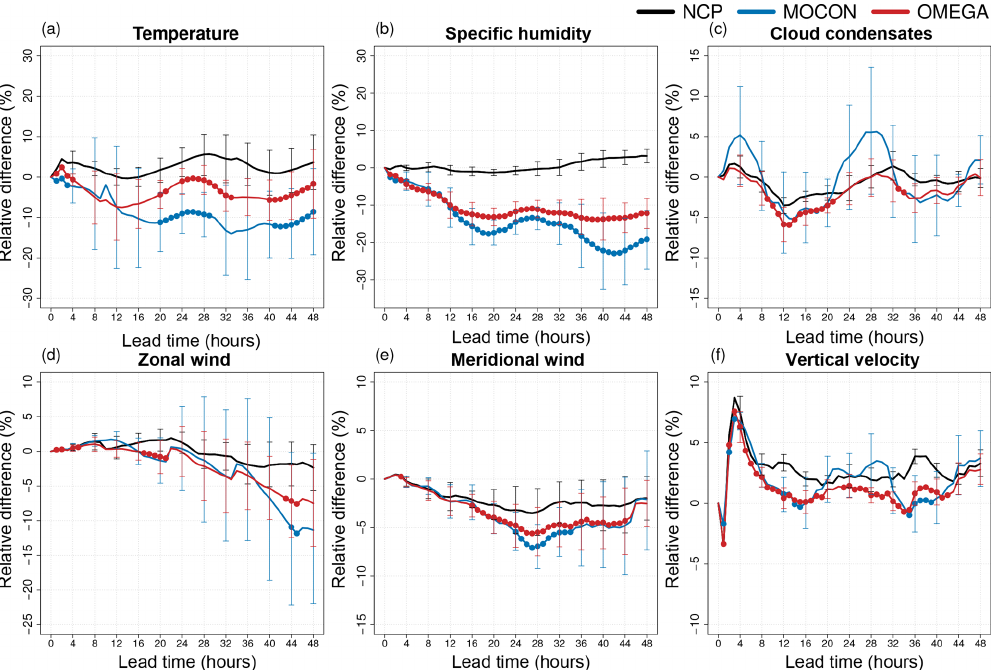
Figure 15. CRPS of the NCP (black), MOCON (blue) and OMEGA (red) ensemble for temperature (a) , specific humidity (b) , cloud con- densates (c) , zonal (d) and meridional (e) wind, and vertical velocity (f) at 250hPa. All ensemble forecasts are performed with perturbations in ICs and LBCs. Error bars show the 95% confidence interval. Lead times where the ensemble mean RMSE is significantly lower than the NCP control RMSE at the 95% confidence level are indicated with a filled circle.